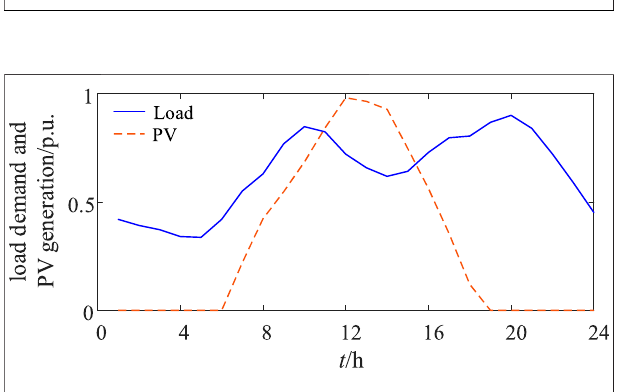
FIGURE 4 | Load demand and PV